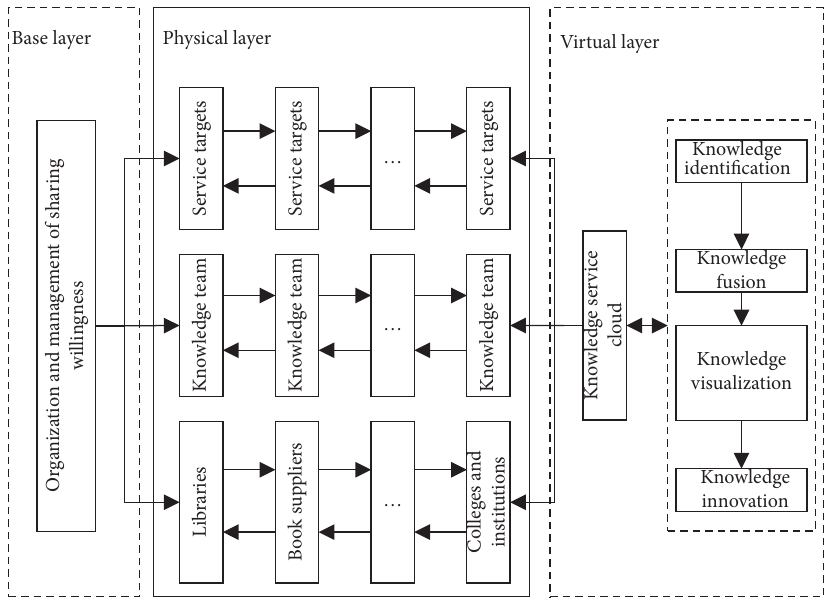
Figure 4: SSS of